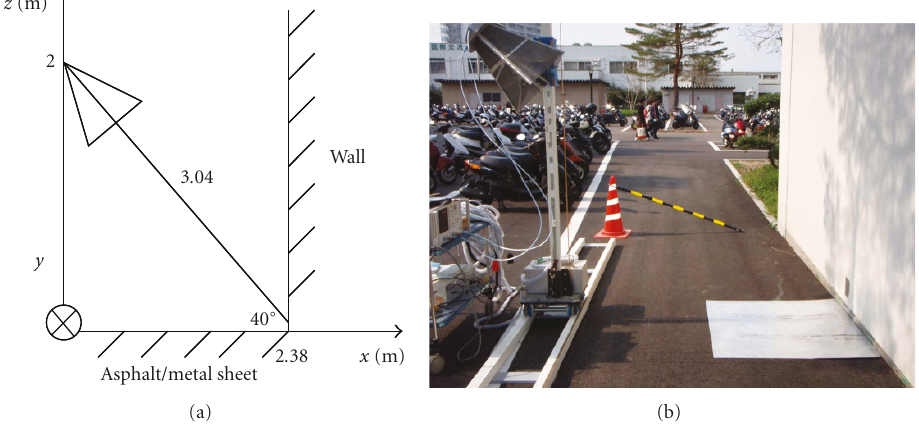
Figure 1: Configuration and photo of the preliminary experiment to test double bounce scattering with GB-SAR.